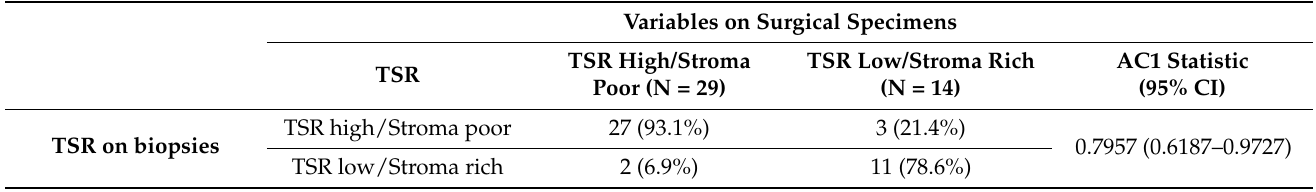
Table 1. Concordance between pathological variables measured on biopsies and on surgical